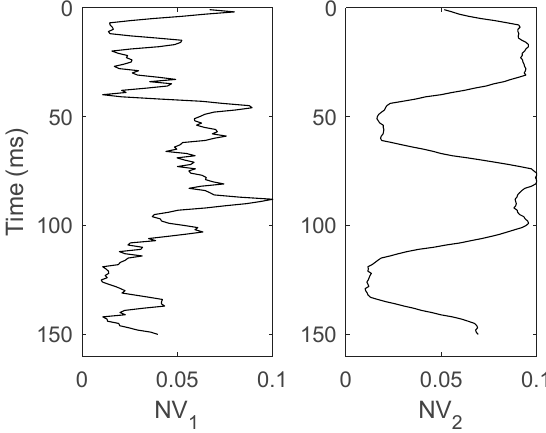
Figure 2. Interpretation results of well log data (fracture density).